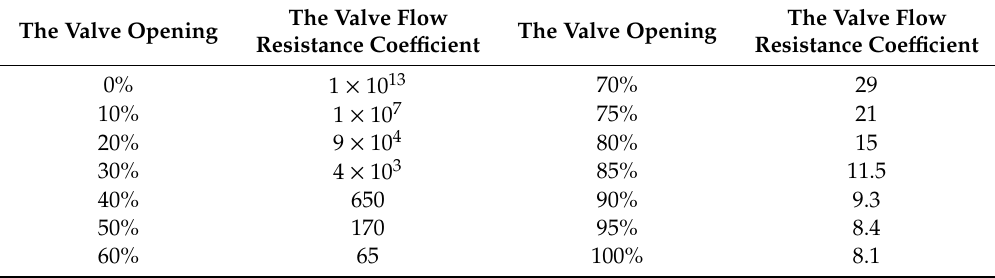
Figure 1. A schematic of the piping system of the Daxing Branch project. Table 1. Relationship between valve opening and valve flow resistance coefficient.